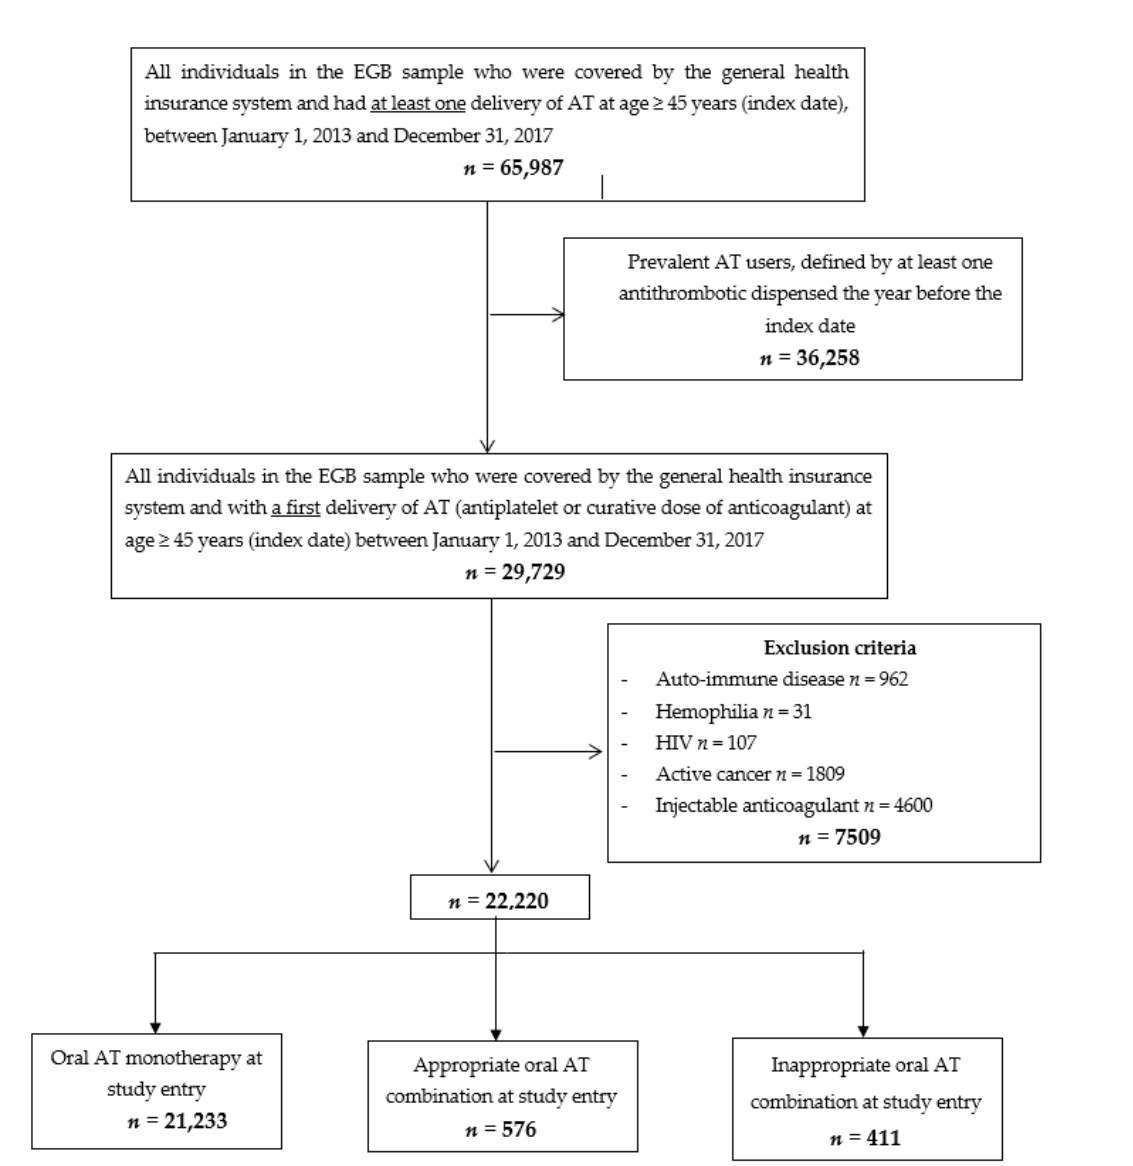
Figure 1. Flow chart.